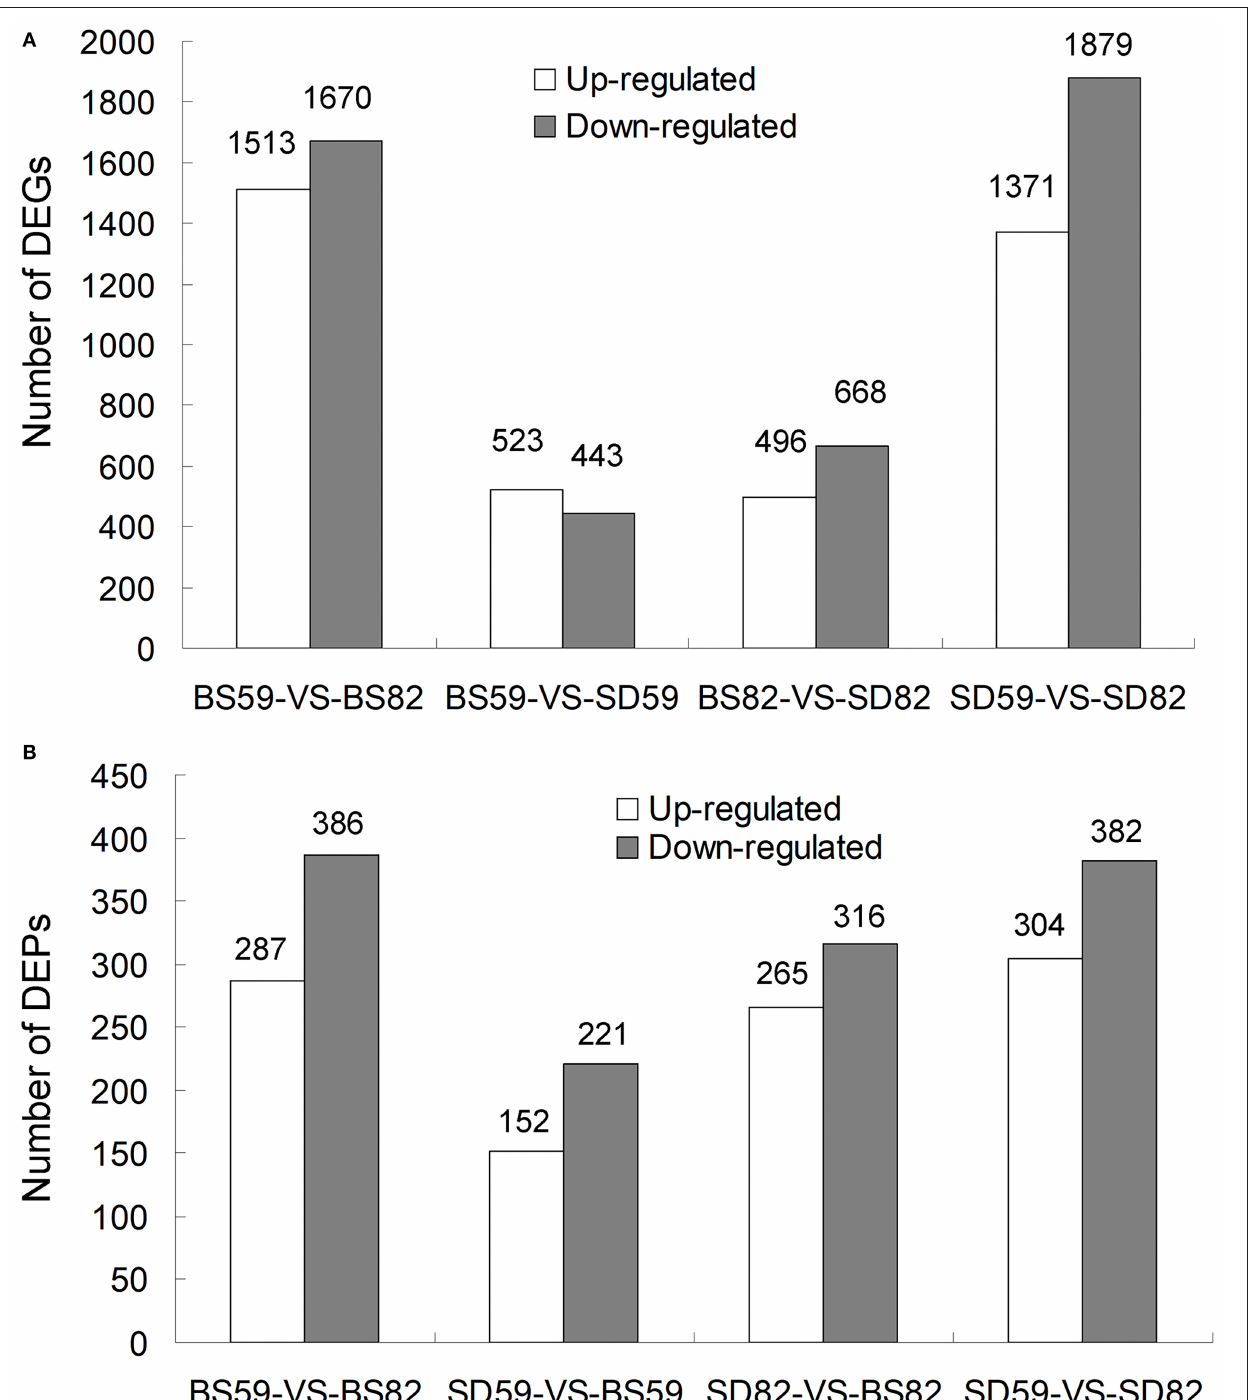
FIGURE 1 | Overview of proteome and transcriptome data analysis. (A) Number of DEGs (differentially expressed genes) at two time points of taproot growth rate (59 DAE and 82 DAE) in the BS and SD cultivars. (B) Number of DEPs (differentially expressed proteins) at two time points of taproot growth rate in the BS and SD